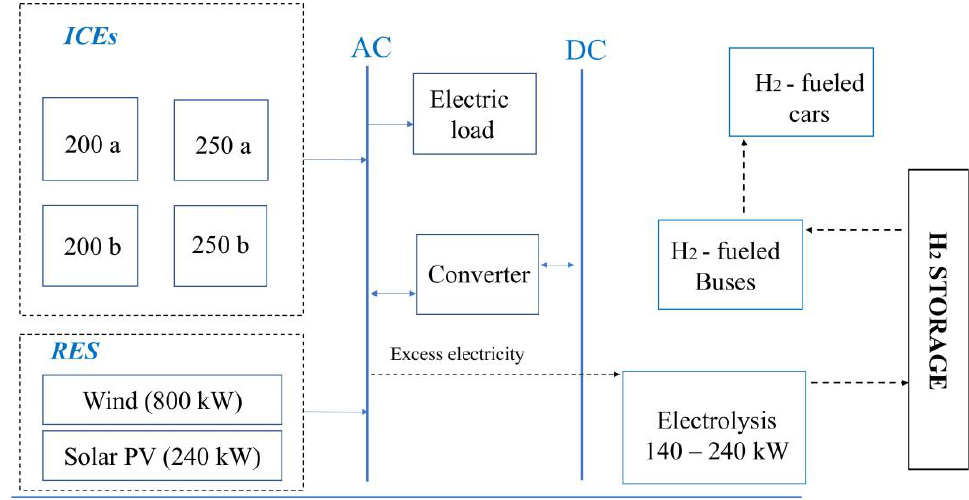
Figure 3. Schematic of the model components—Anafi green island.